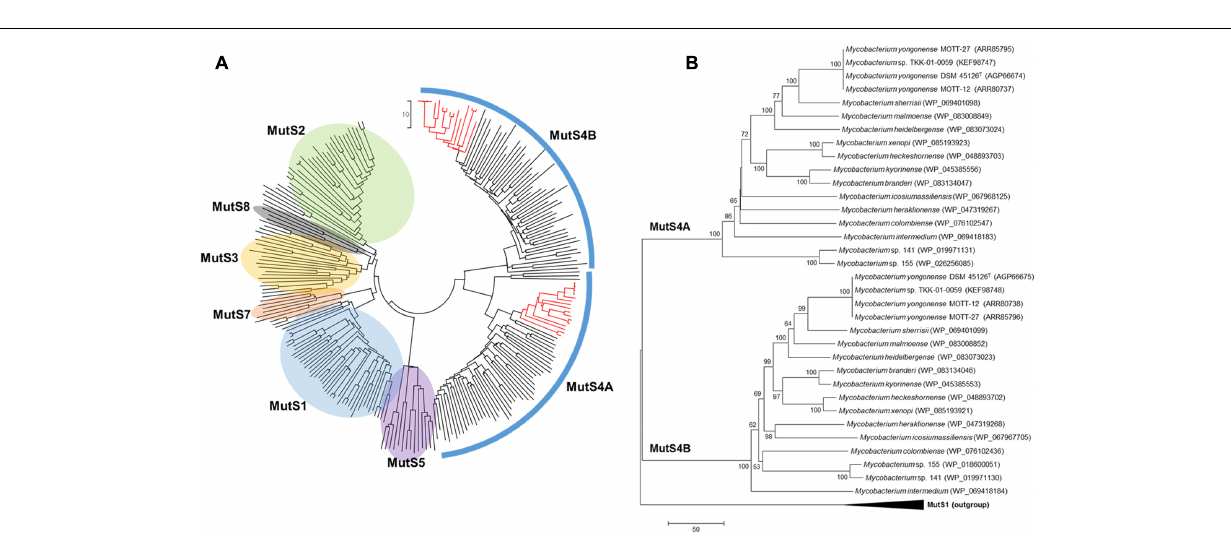
FIGURE 4 | Neighbor-Joining phylogenetic trees of MutS family proteins. (A) Phylogenetic tree covering MutS homologs from diverse bacterial and archaeal strains. Red branches indicate MutS4 homologs of Mycobacterium strains including M. yongonense Type I strains. (B) Phylogenetic tree based on MutS4 homologs among Mycobacterium strains and rooted with MutS1 sequences as an out-group. Evolutionary distances are in units of numbers of amino acid differences per